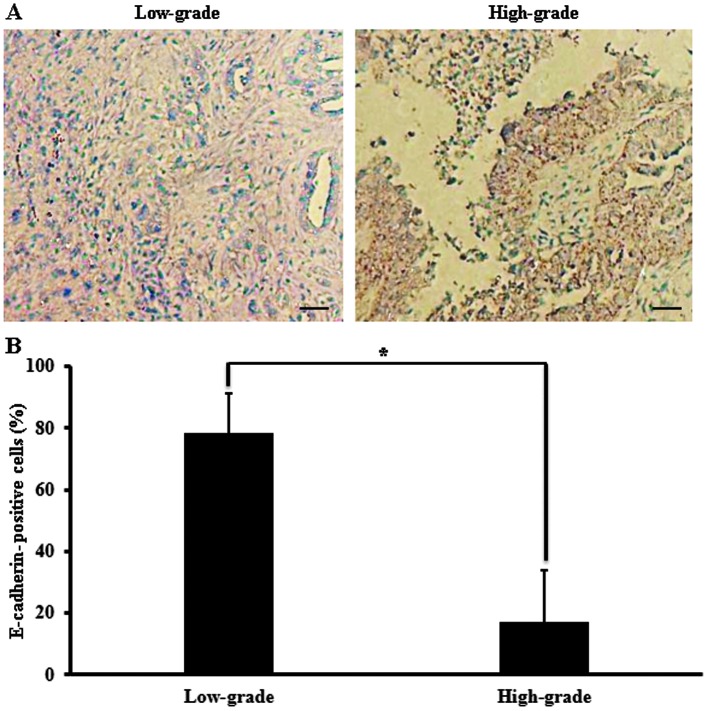
Immunohistochemical staining of E-cadherin in ovarian cancer tissues. (A) Representative images of IHC staining for E-cadherin expression in low- and high-grade tumors. Magnification, ×400. Scale bar, 20 μm. (B) Quantification of E-cadherin-positive cells in the tumors. Five visual fields were randomly selected and 100 cells in each field were counted. Data are presented as the percentage of the total number of positive cells relative to the total 100 cells counted. Values are means ± SD, n=5. *P<0.05.